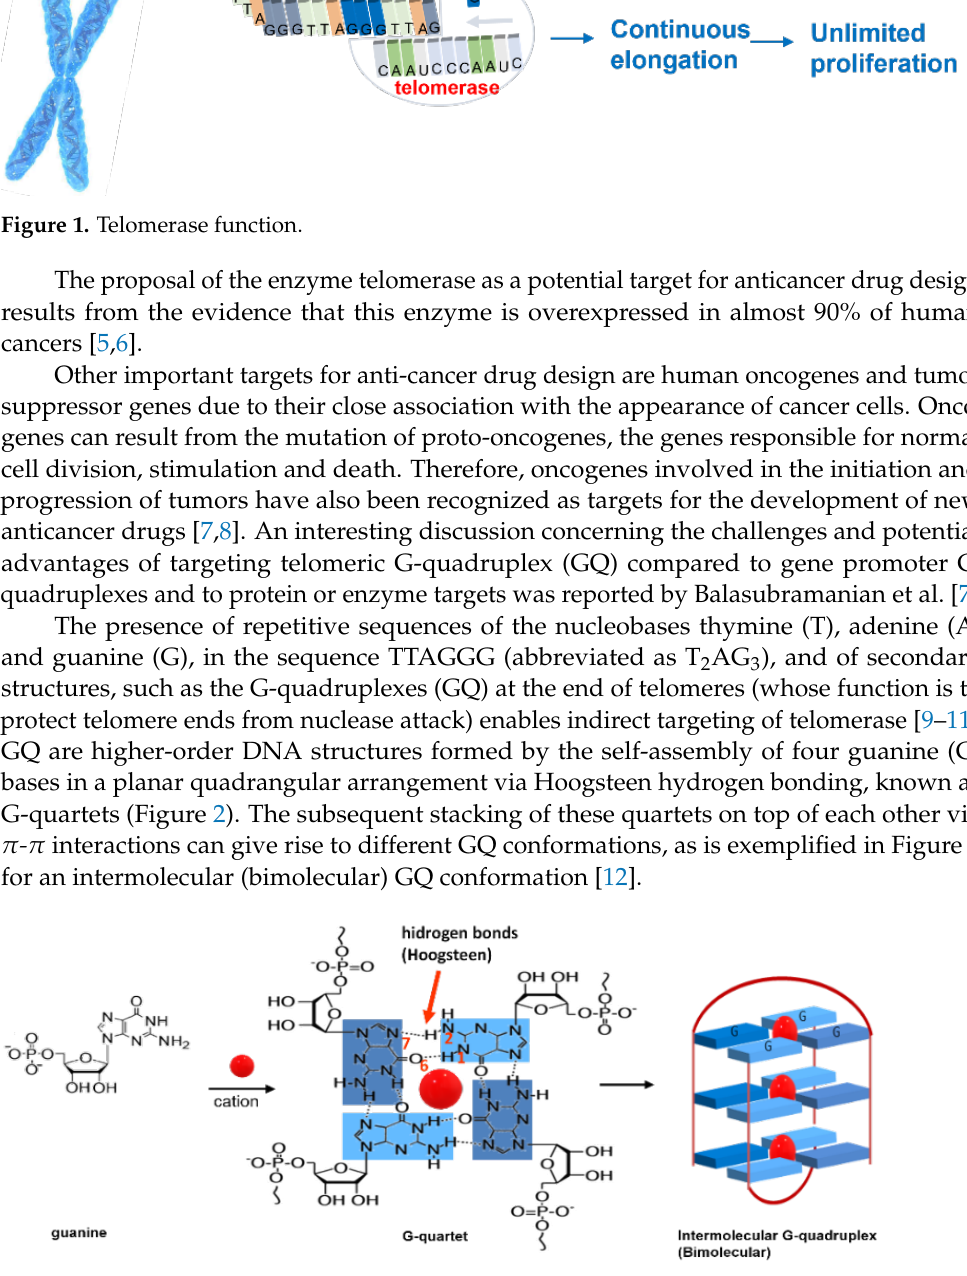
Figure 1. Telomerase function.